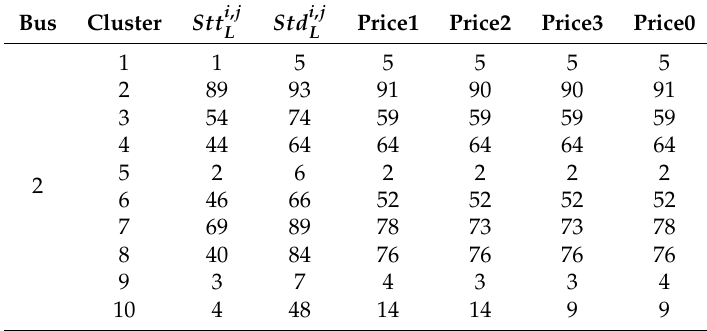
for DR loads of various pricing options on bus 2. L